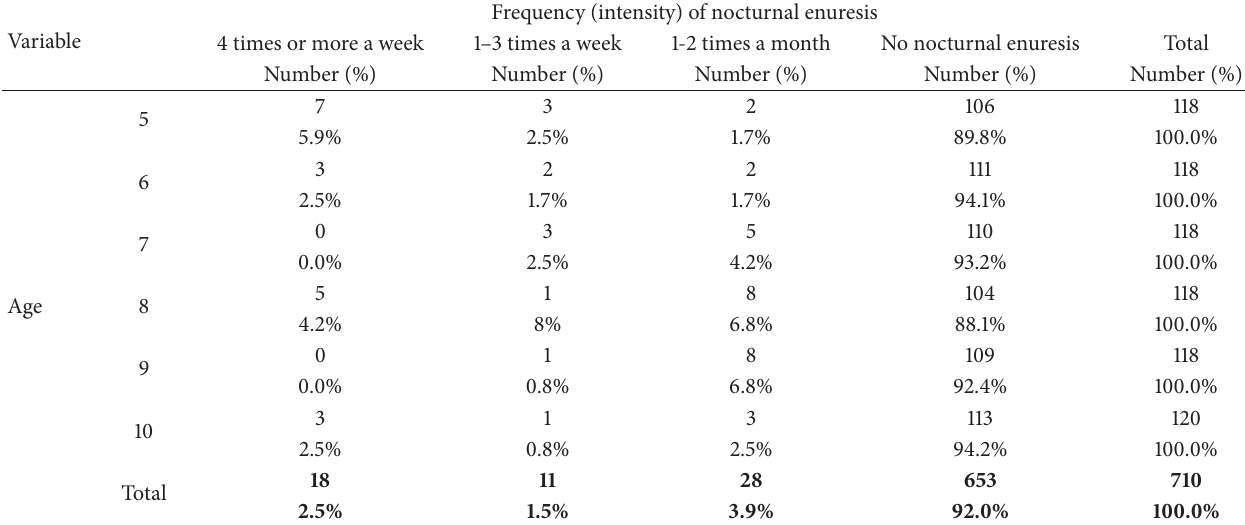
Table 2: Frequency of nocturnal enuresis in the children in terms of age group.